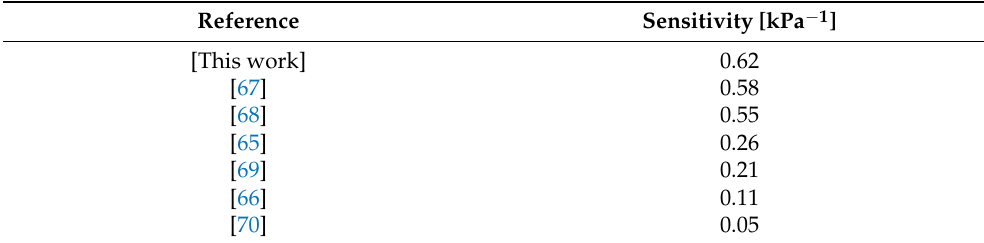
Table 1. A comparison of performance between our study and other types of pressure sensors previously